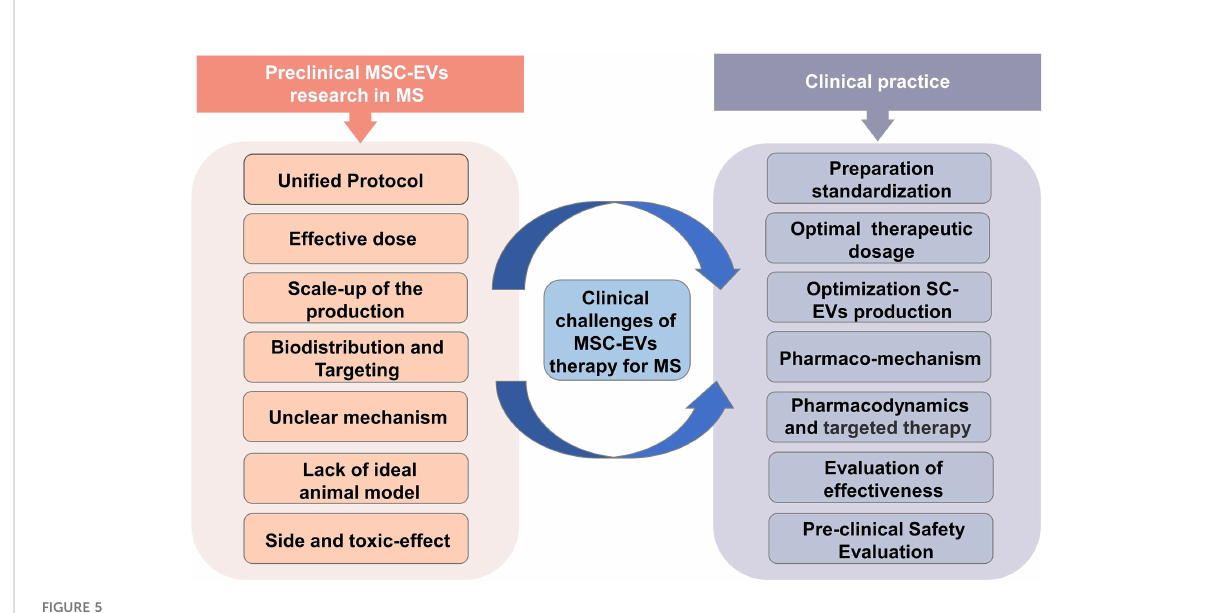
FIGURE 5 Clinical challenges of MSC-EVs therapy for